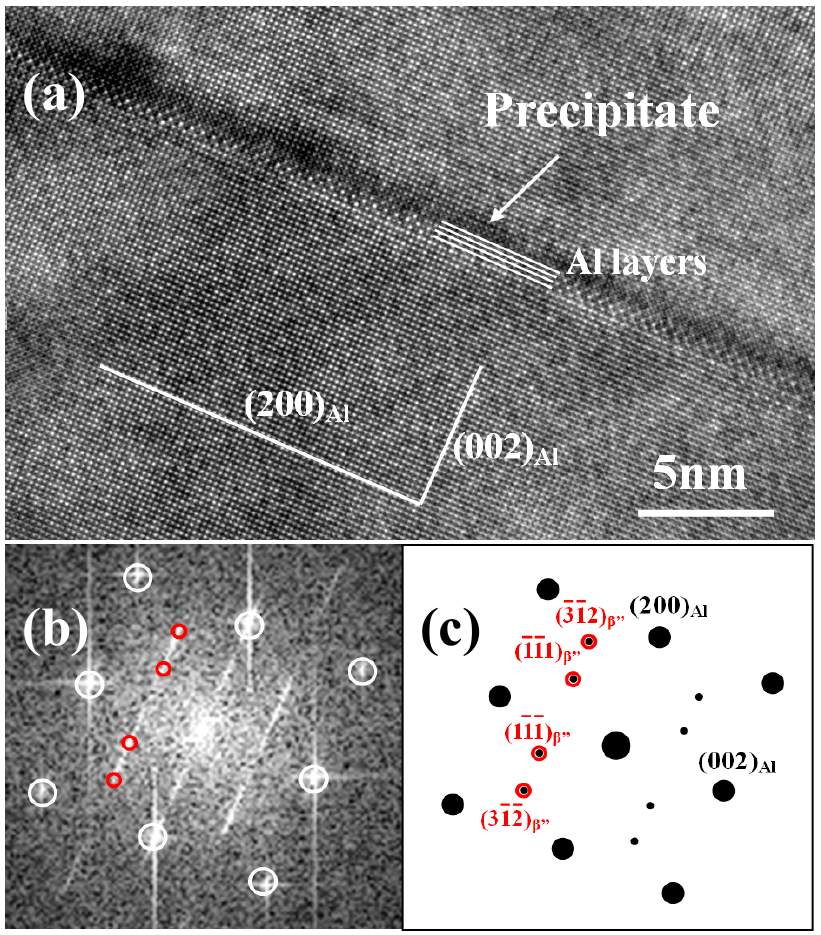
Figure 13. Acicular precipitate in the peak-aged Alloy 1 (165 °C/360 min) observed via the <010> Al direction: ( a ) HRTEM image; ( b ) corresponding FFT; ( c ) simulated pattern.